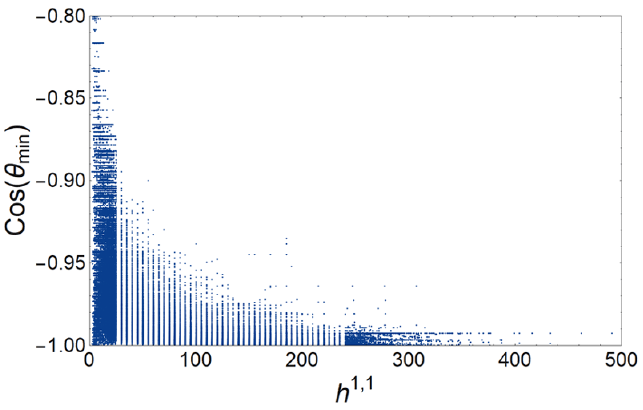
Figure 3. cos( (cid:18) min ), de(cid:12)ned in (6.2), vs. h 1 ; 1